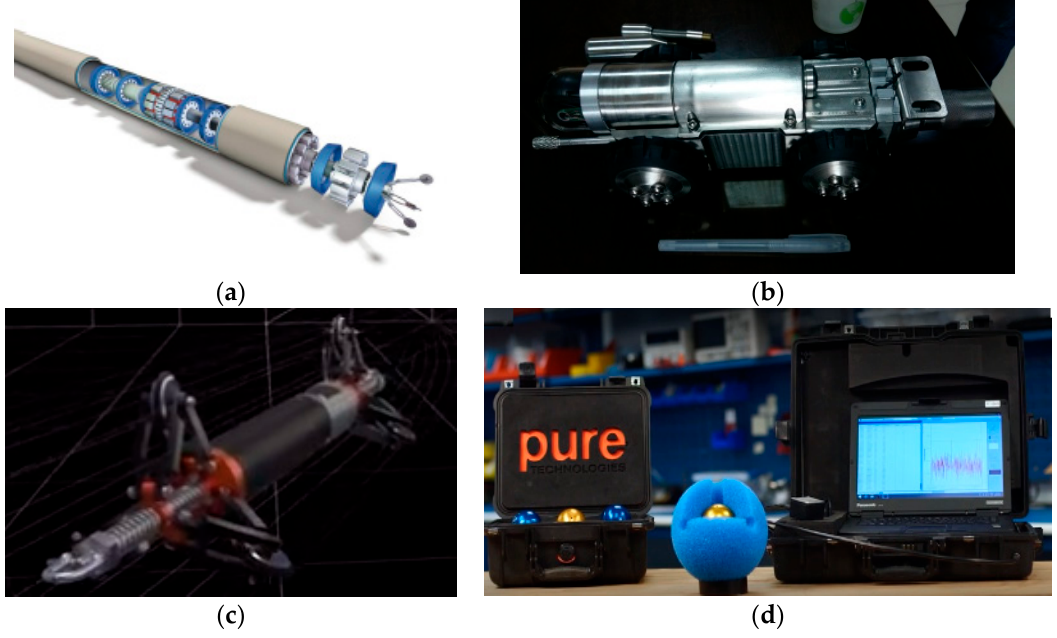
Figure 1. The intelligent Pipeline Inspection Gauges (PIGs) for small-diameter pipeline surveying. ( a ) Regular smart PIG. ( b ) Remote PIG. ( c ) Gyroscopic PIG. ( d ) SmartBall PIG.